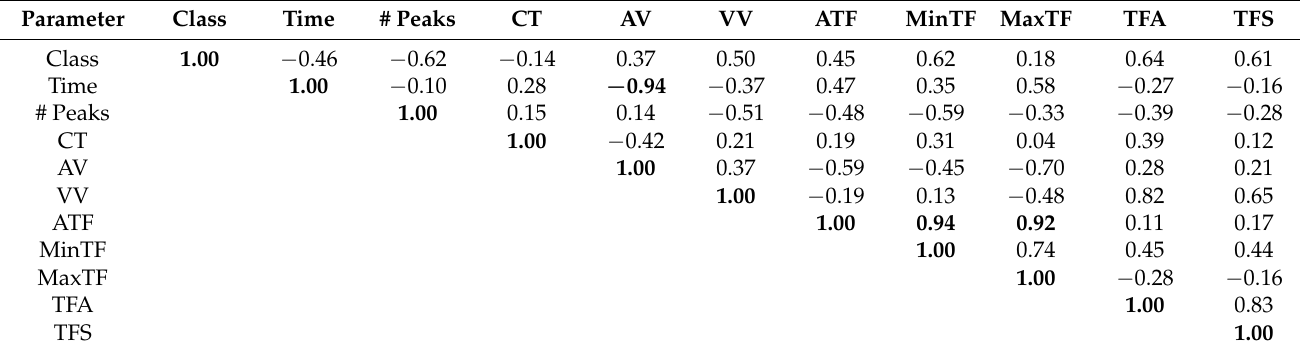
Table 3. Pearson Correlation coefficients (R) between kinematic and spatiotemporal parame- ters monitored. Correlation coefficients greater than 0.9 in absolute value are presented in bold. [Class = Classification level; Time = time to perform 400 m; # peaks = number of peaks in